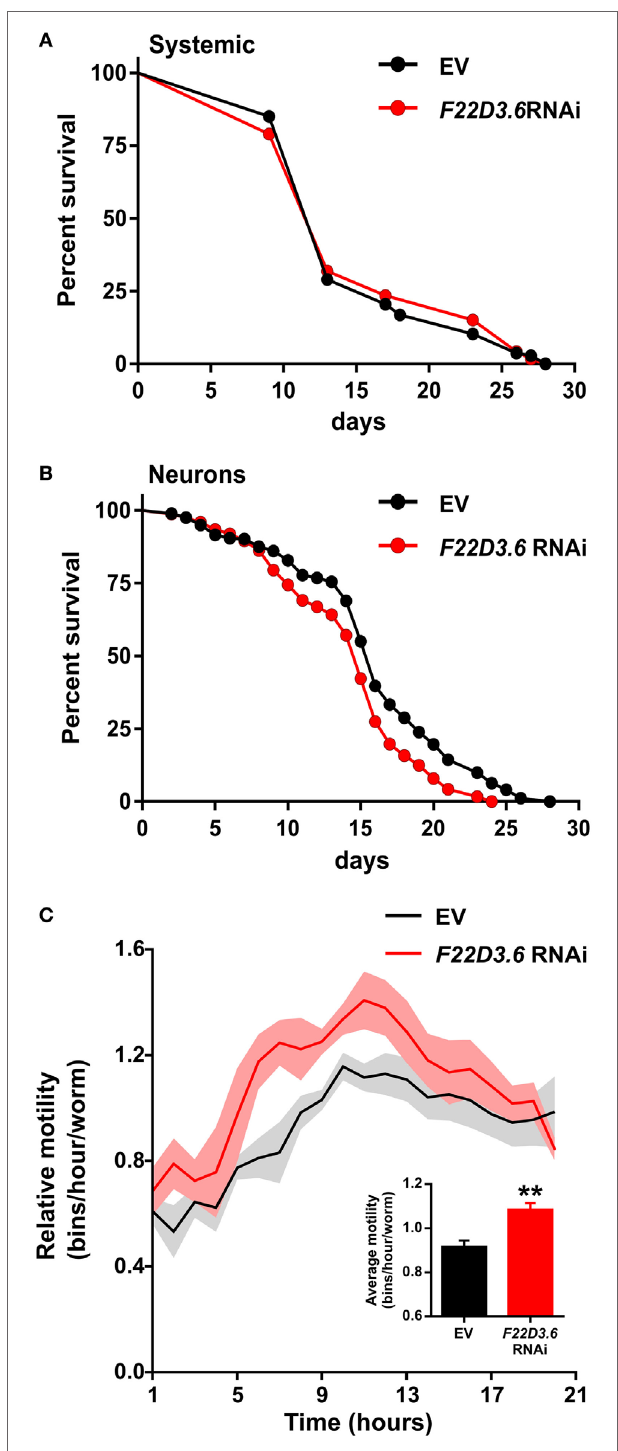
FigUre 8 | CBM and NF- κ B-independent functions of the type 1 paracaspase malt1 in Caenorhabditis elegans . (a) Wild-type (N2 strain) C. elegans worms were fed E. coli expressing RNAi targeting malt1 ( N = 119) and regularly monitored for viability compared to worms fed control RNAi ( N = 107). No difference in life span could be detected ( p = 0.8194). In these wild-type worms, RNAi is typically targeting every cell except neurons. Silencing in the wild-type N2 strain resulted in approximately 60% reduction of total malt1 expression levels, indicating efficient silencing in the non- neuronal cells. (B) Neuronal RNAi importer transgenic (TU3311 strain; unc-119p:sid-1 transgenic) C. elegans worms were fed E. coli expressing RNAi targeting malt1 ( N = 399) and regularly monitored for viability compared to worms fed control RNAi ( N = 364). A reproducible and significant ( p = 1.4 × 10 − 7 ) drop in survival was seen upon silencing malt1 in the neuronal system. (c) Neuronal RNAi importer transgenic (TU3311 strain; unc-119p:sid-1 transgenic) C. elegans worms were fed E. coli expressing RNAi targeting malt1 and monitored for motility, using the Wmicrotracker device, compared to worms fed control RNAi. Panels (a–c) represent pooled results of three biological replicates carried out at